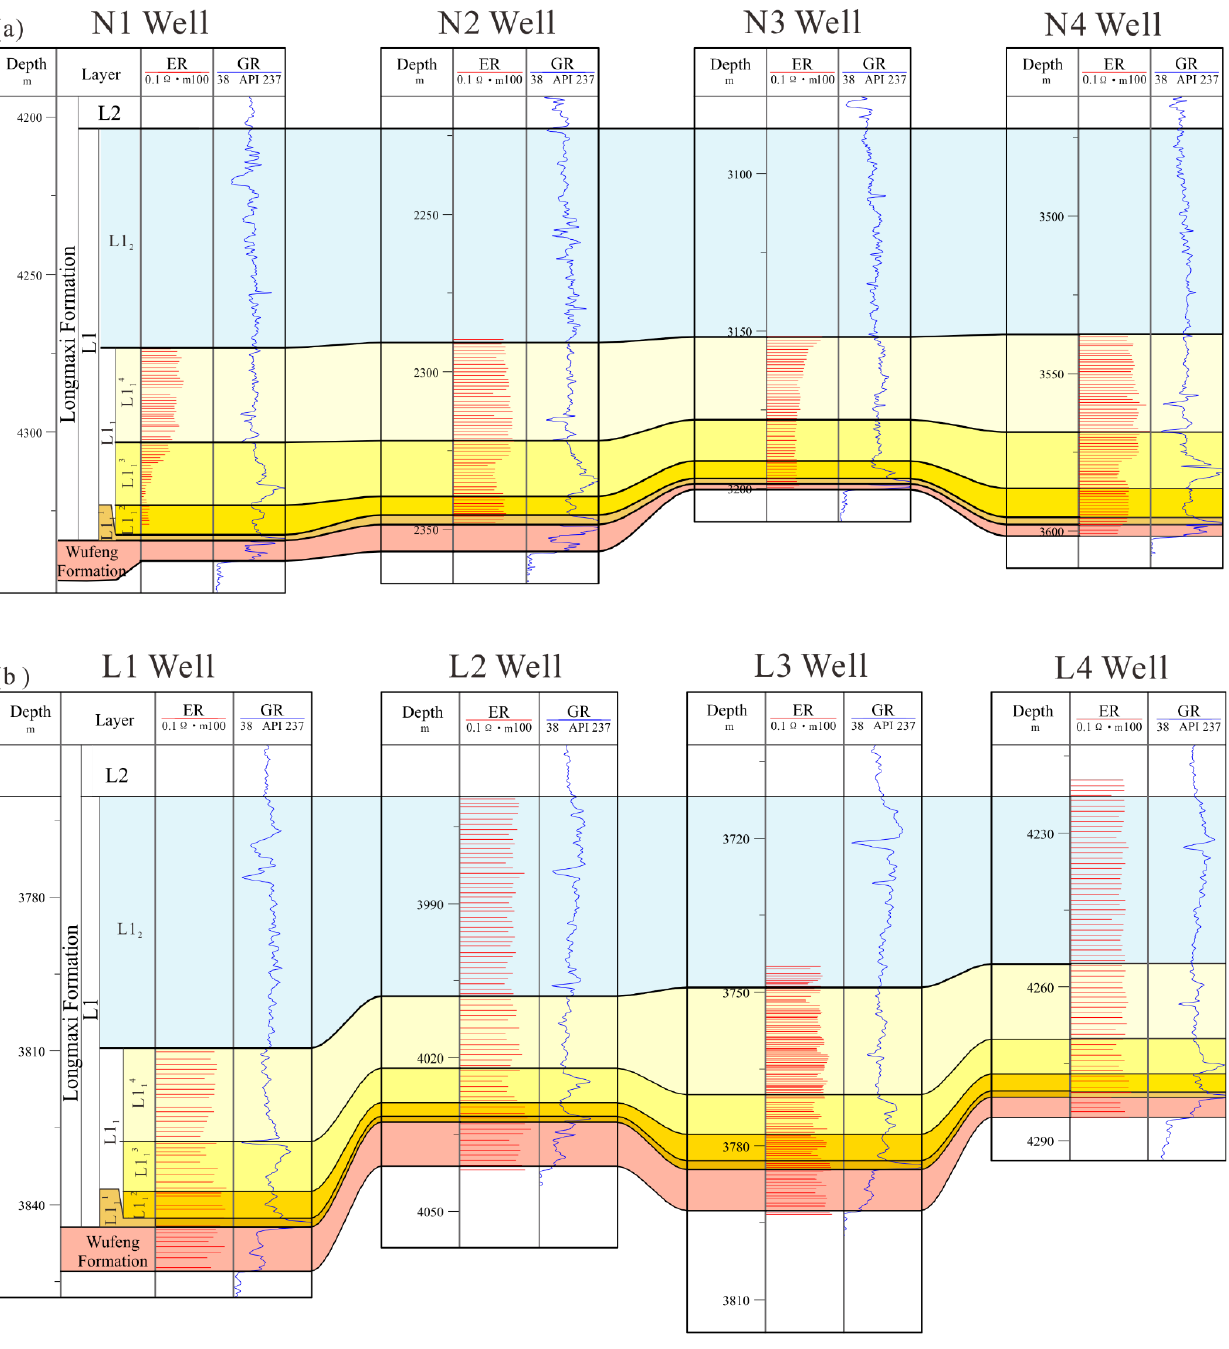
Figure 2. Sedimentation sections of eight sampled wells at the Changning block ( a ) and Luzhou ( b ).ER: Electrical resistivity; GR: Gamma block ( b ) . ER: Electrical resistivity; GR: Gamma ray.